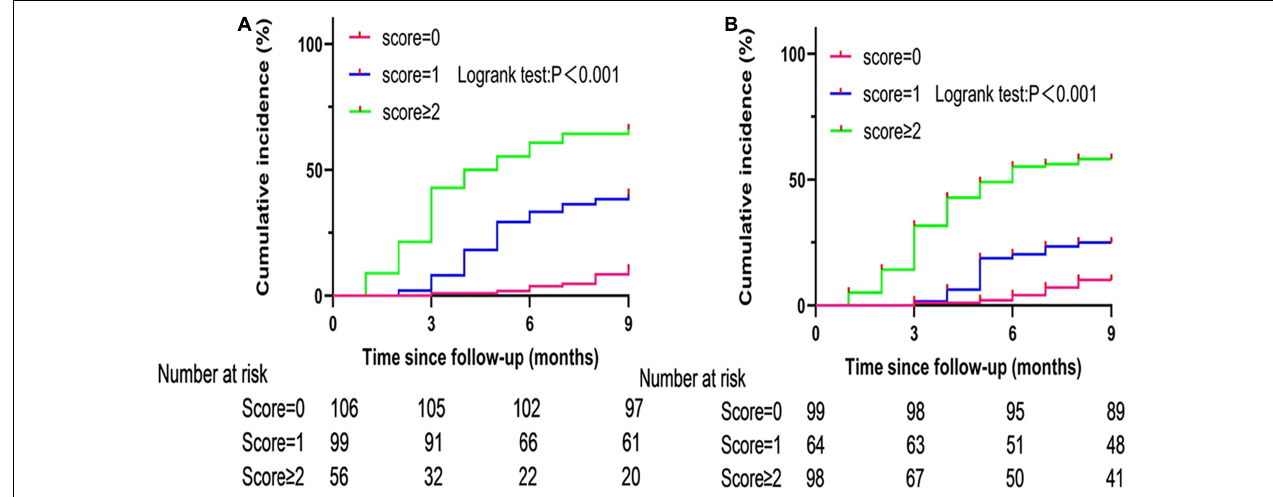
FIGURE 2 | Cumulative incidence curves of atrial fibrillation recurrence stratified by C2HEST (A) and HATCH (B)